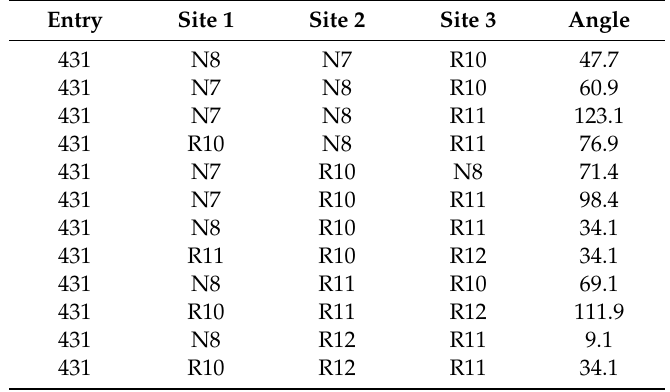
Table 3. The intersite angles between the selected pharmacophore hypotheses.